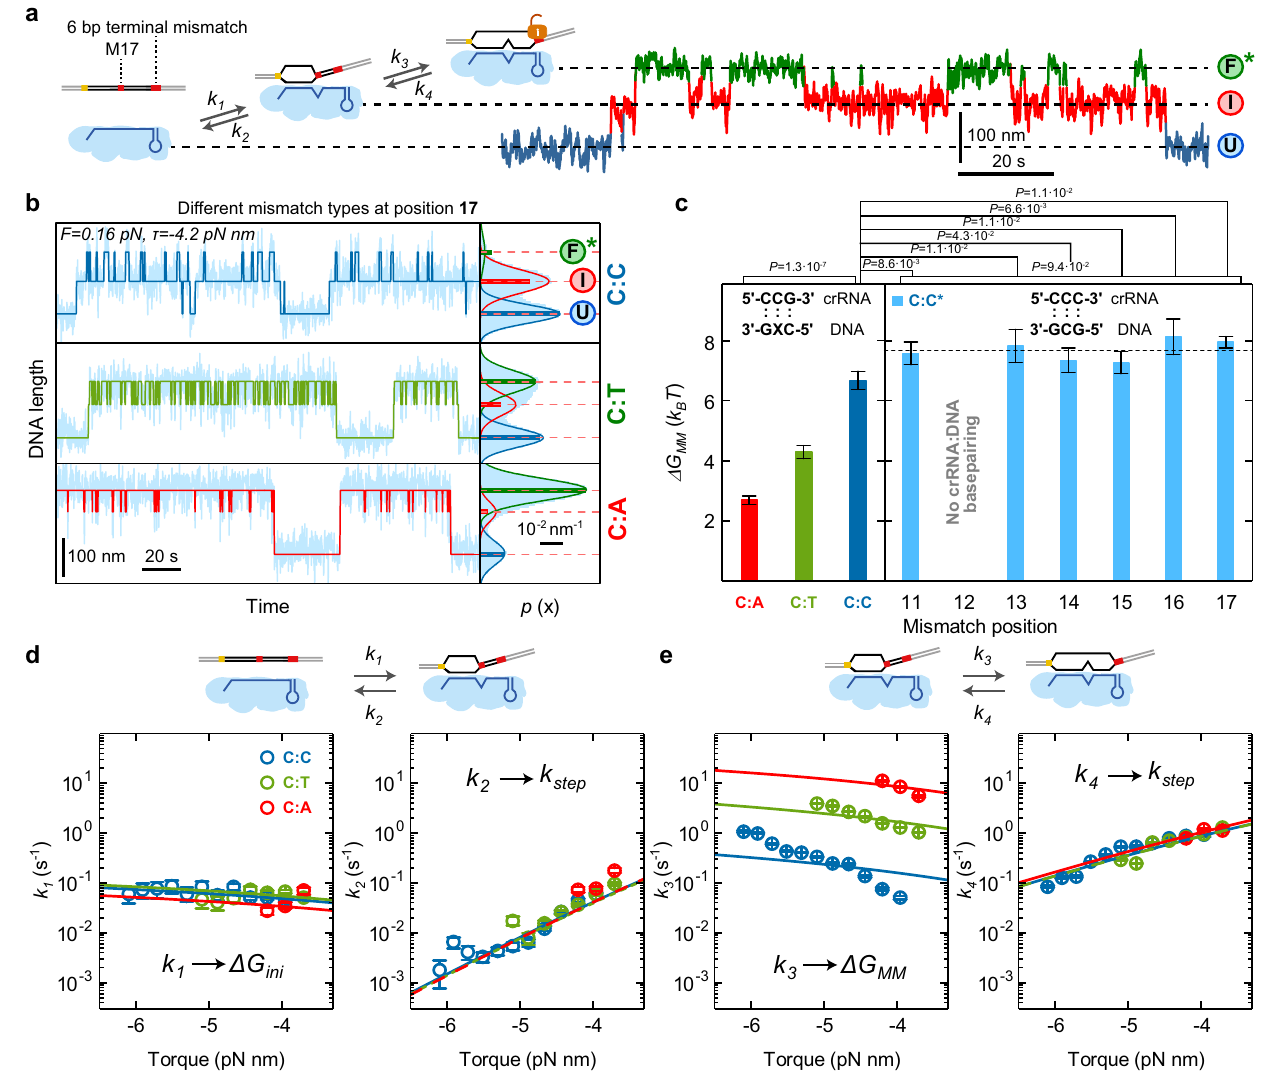
Fig. 3 | R-loop dynamics on locking-de fi cient targets containing a single internal mismatch. a Sketch of the DNA target with mismatched bases shown in redandthepossibleR-loopstates — theunboundstate( U ),theintermediateR-loop ( I ) and the almost full but unlocked R-loop ( F * ). Sequential transitions between these states can be described by 4 different rate constants ( k 1 to k 4 ) as indicated. Example trajectory of the transitions between the different states measured for a C:C mismatch. b Trajectories and histograms of the DNA length recorded for tar- gets with either a C:C, C:A, or a C:T mismatchat a torque of 4.2pNnm (light blue). 3-state approximations of the trajectories are shown in dark blue (C:C mismatch), green(C:Tmismatch)orred(C:Tmismatch).Solidlinesinthehistogramsrepresent Gaussian fi ts to the 3 different states, while horizontal dashed lines indicate the average DNA length of each state. Bars represent theoretically predicted